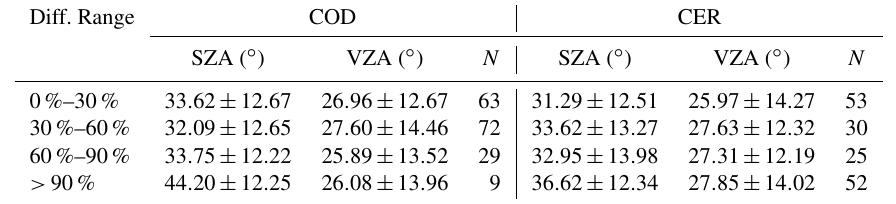
Table 3. Mean values of SZA and VZA for different levels of differences in ice cloud properties observed by sky radiometer and SGLI. Diff. Range